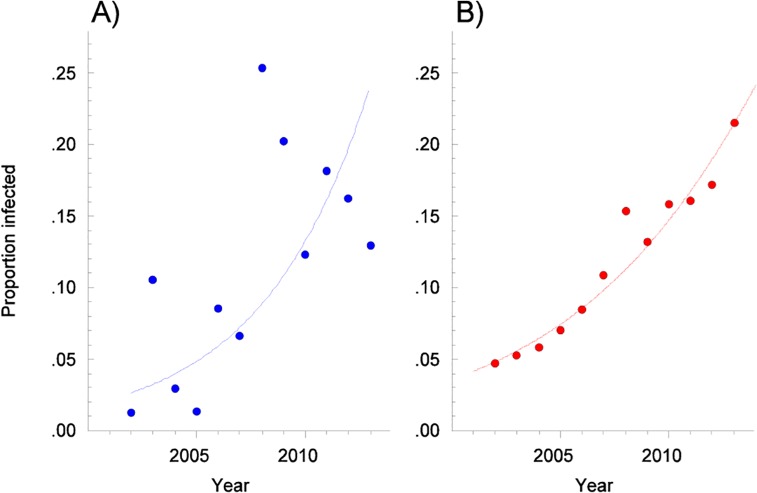
A) Proportion of grey seals (Halichoerus grypus) from the Baltic coast of Sweden infected with Pseudamphistomum truncatum per year from 2002 to 2013 unadjusted for explanatory variables. The proportion of infected seals increases significantly over time (p<0.01, log-linear regression). B) Predicted proportion of grey seals from the Baltic coast of Sweden infected with P. truncatum per year from 2002 to 2013, adjusted proportions using an average of 8 years of age and observed mean values for sex and cause of death. This reduces the variance in the logistic model (p< 0.001, full logistic model compared to intercept only).